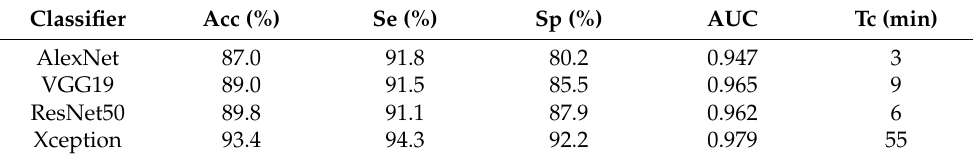
Table 2. Performance of four types of neural networks in the ST-CWT datasets.